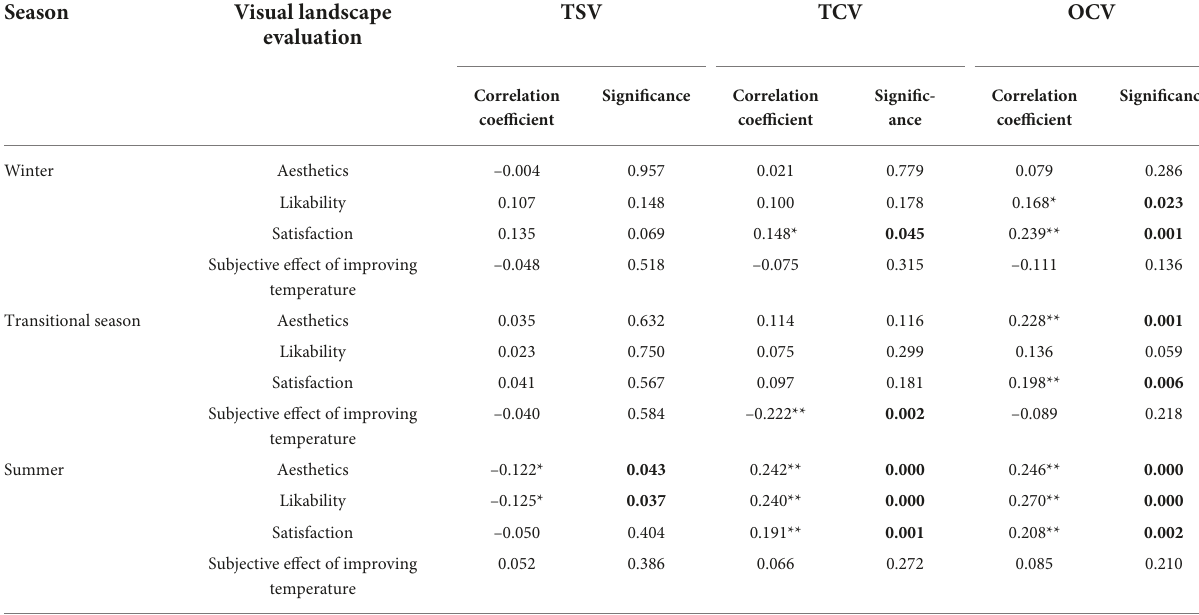
TABLE 9 Correlation analysis of visual landscape evaluations and subjective environmental